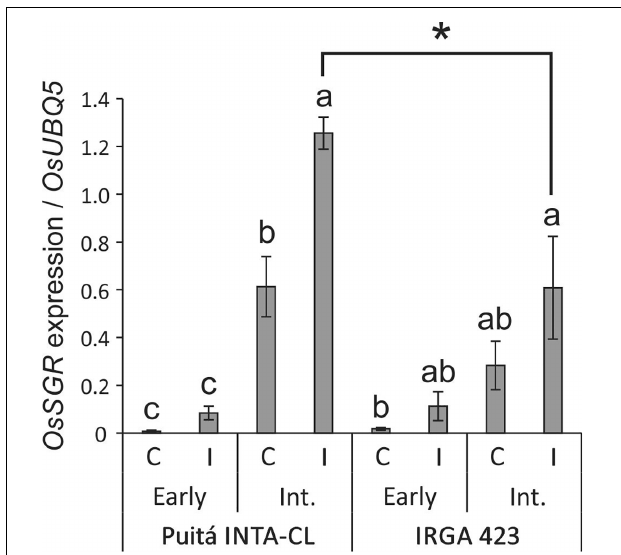
FIGURE 3 | OsSGR expression in control and early and intermediate infested leaves of the two tested cultivars (Puitá INTA-CL and IRGA 423). Represented values are the averages of three samples ± SE. Different letters indicate that the means (from each cultivar) are different by the Tukey’s HSD test ( P ≤ 0.05). Mean values with one asterisk are significantly different as determined by the Student’s t -test ( P ≤